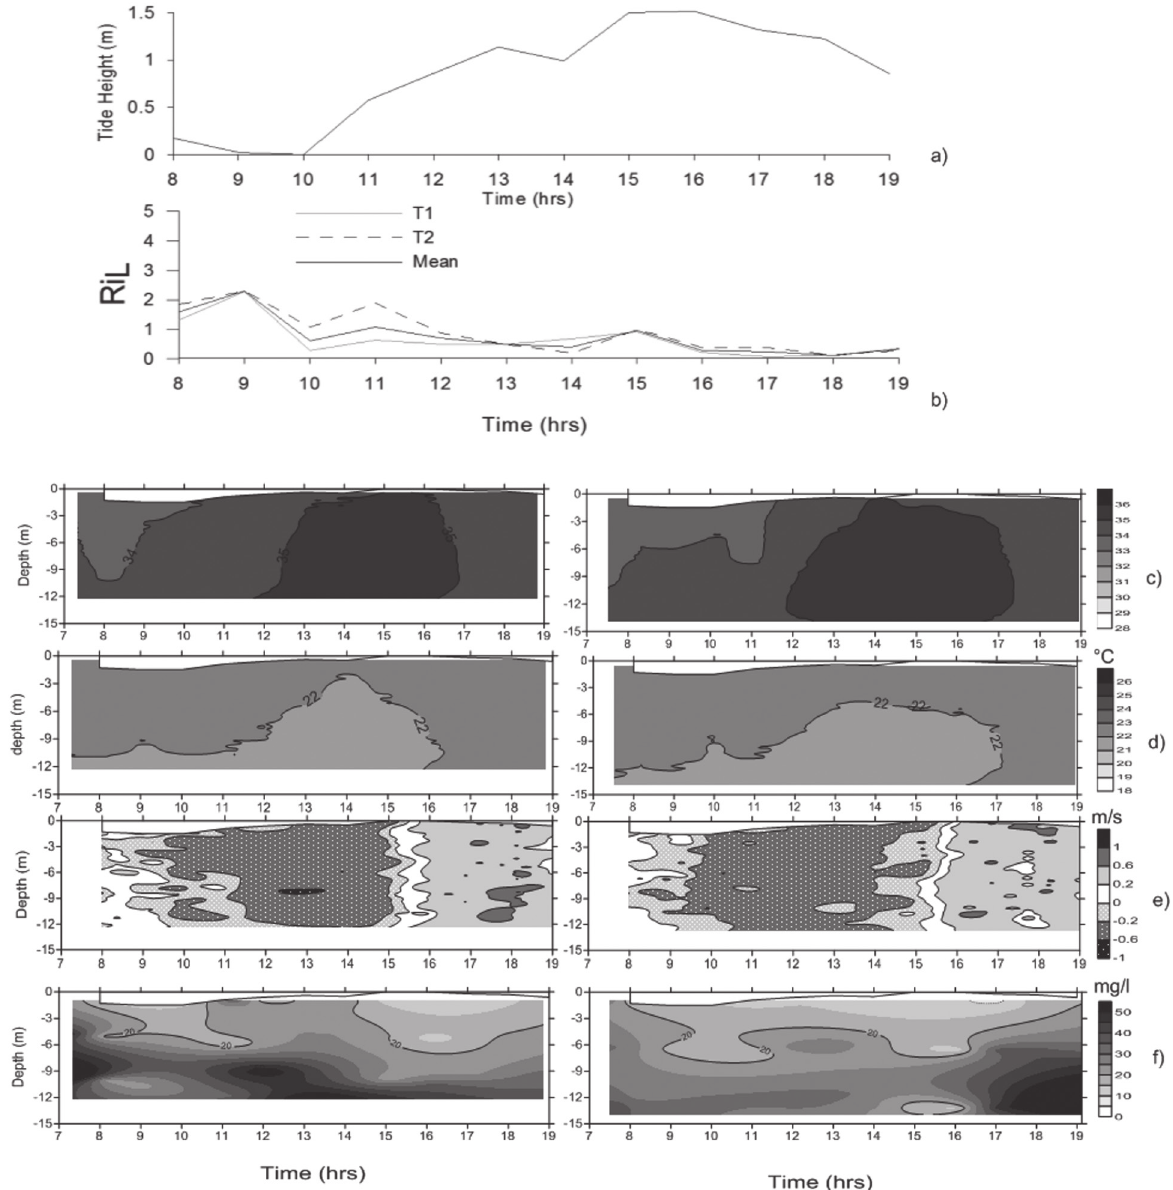
Figure 4 - Temporal profiles of SS (spring cycle during the dry season - 09/22/2010); a) tide elevation (m); b) Layer Richardson number; c) salinity (PSU) d) temperature (°C); e) longitudinal velocity (m/s); f) SPM (mg/L); Left column is station T1 and right column station T2. Different scale due to